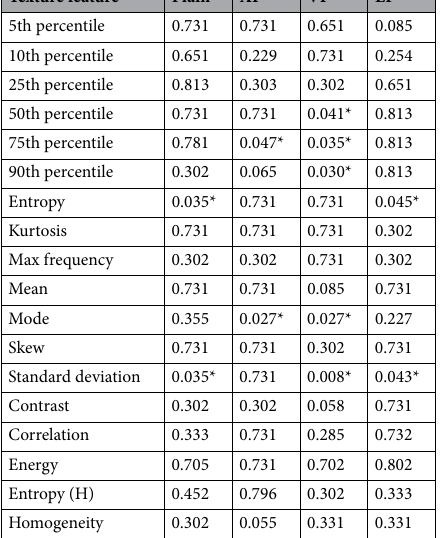
Table 1. Mann–Whitney U test of each texture feature in multiphase contrast-enhanced CT imaging in differentiating ICC with isocitrate dehydrogenase (IDH) mutation from those without. AP arterial phase, VP portal venous phase, EP equilibrium phase. Data are p value; *p < 0.05.